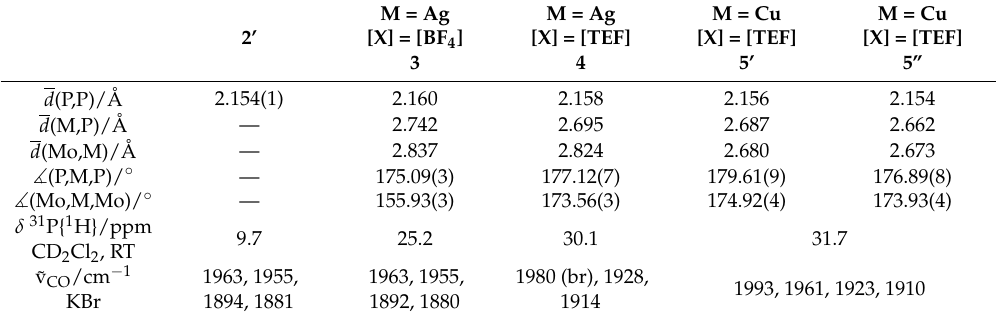
Table 1. Comparison of structural and spectroscopic data of the compounds [M( 2 ) 2 ][X] and the triple-decker complex 2’